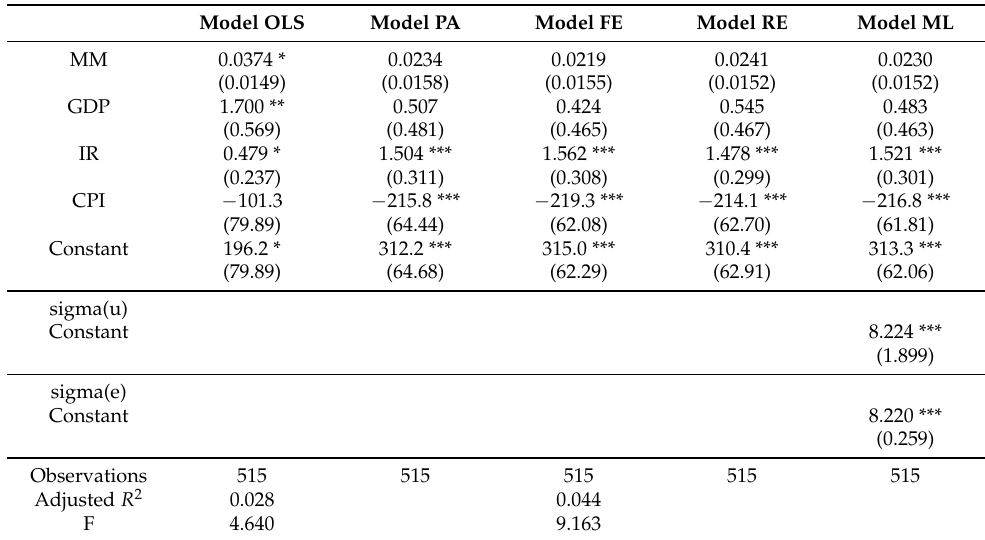
Table A11. Panel Regression Table OM Model